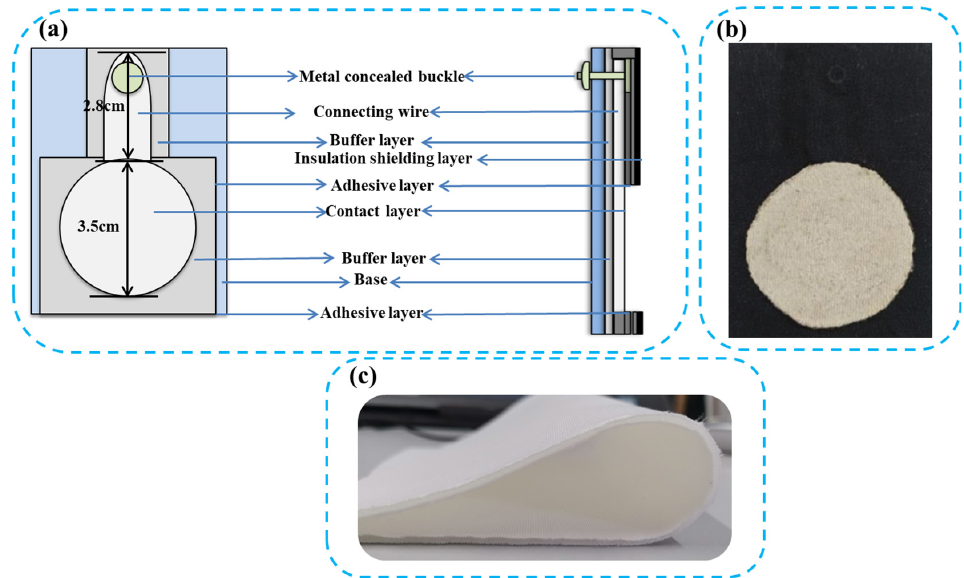
Figure 1. ( a ) Schematic diagram of the structure of the silver-plated fabric electrode. ( b ) Physical drawings of the silver-plated fabric electrodes. ( c ) Space cotton fabric.